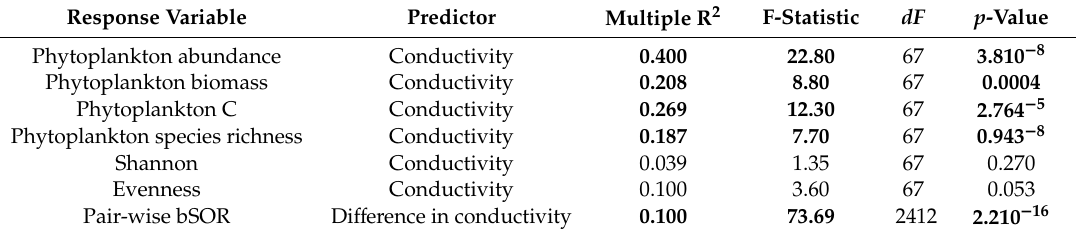
Table 3. Statistics of the constructed non-linear regression models. Significant relationships ( p -value < 0.05) are in